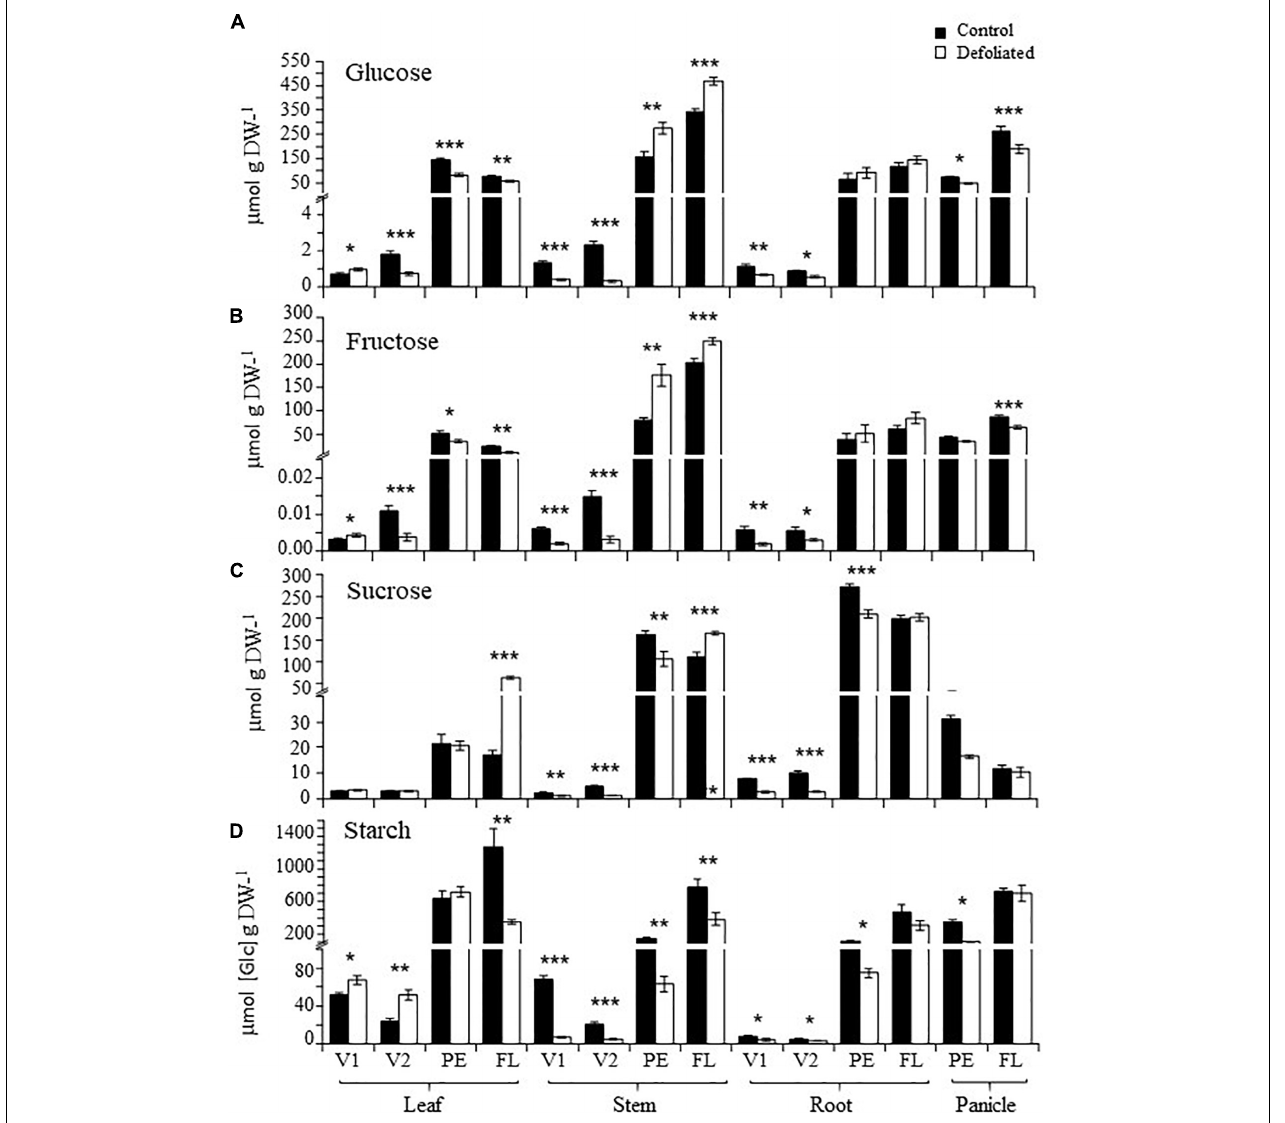
FIGURE 1 | Non-structural carbohydrate content in organs of defoliated versus non-defoliated Amaranthus cruentus plants. Levels of ( A ) glucose, ( B ) fructose, ( C ) sucrose, and ( D ) starch were determined in leaves, stems, roots, and panicles of A. cruentus plants subjected to complete defoliation at four different development stages: Vegetative 1 (V1), vegetative 2 (V2), panicle emergence (PE), and flowering (FL). The bars represent the means ± standard error of three technical replicates obtained from three pooled plant samples produced by combining organs from nine individual plants. The results are from a representative experiment that was replicated twice. Asterisks indicate statistically significant differences between treatments at * P < 0.05, ** P < 0.01, or *** P < 0.001 for a one-way ANOVA, Tukey HSD